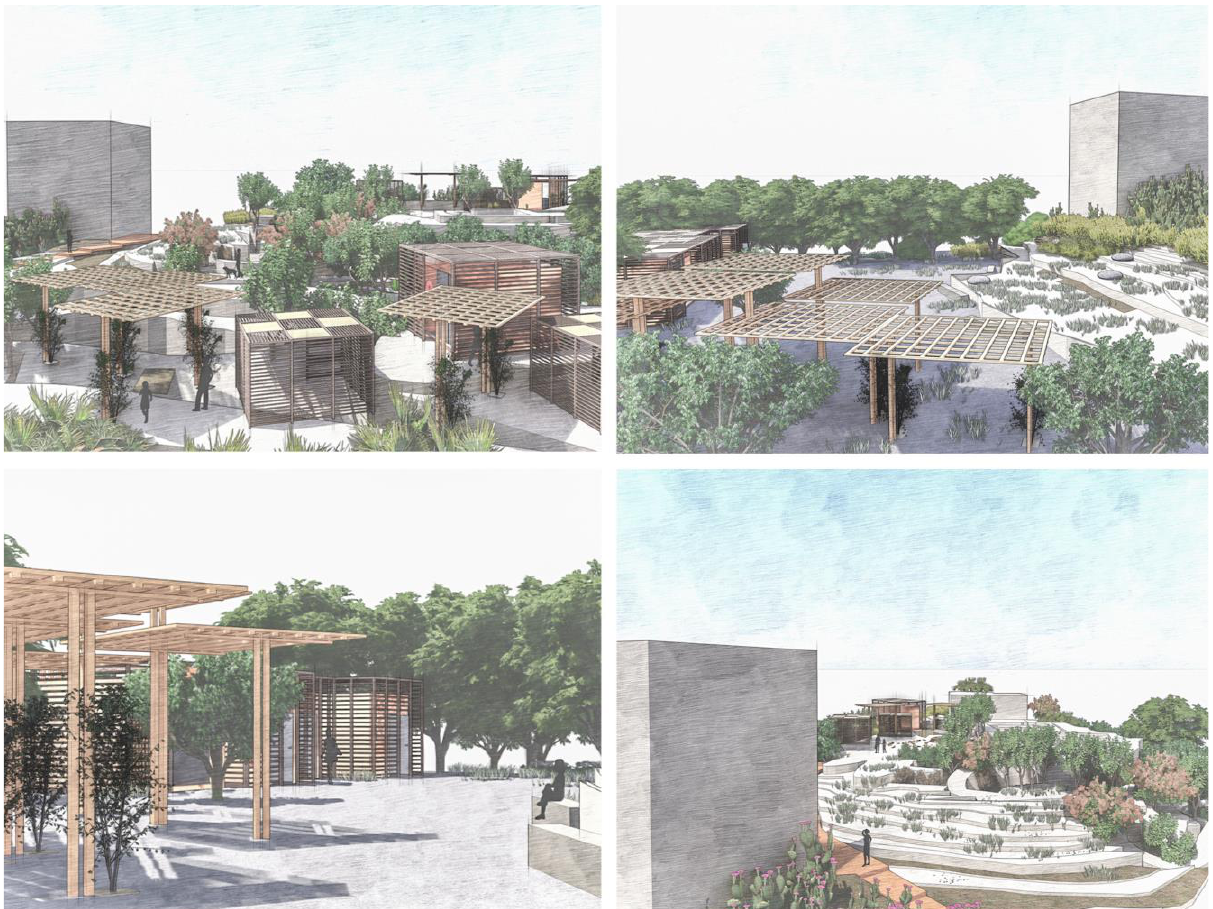
Figure 7. Site enhancement proposals for the castle of